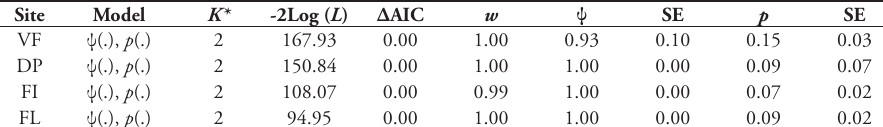
fied for overdispersion (Burnham and Anderson 2002) and Akaike weight, w , are reported for each model. Both ψ and p were constant (.) within the time interval between the first and last survey of each study